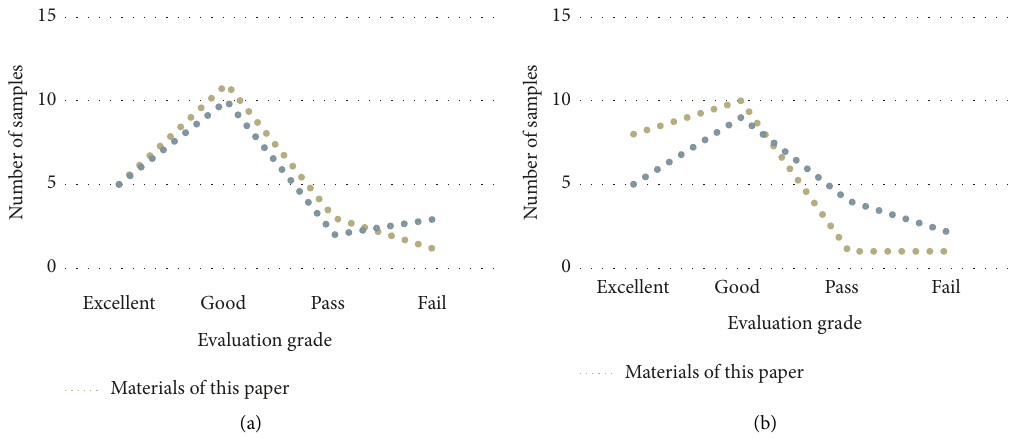
Figure 9: Fashion and texture harmony test. (a) shows the style popularity test of two design materials. (b) shows the texture harmony test of the two design materials.